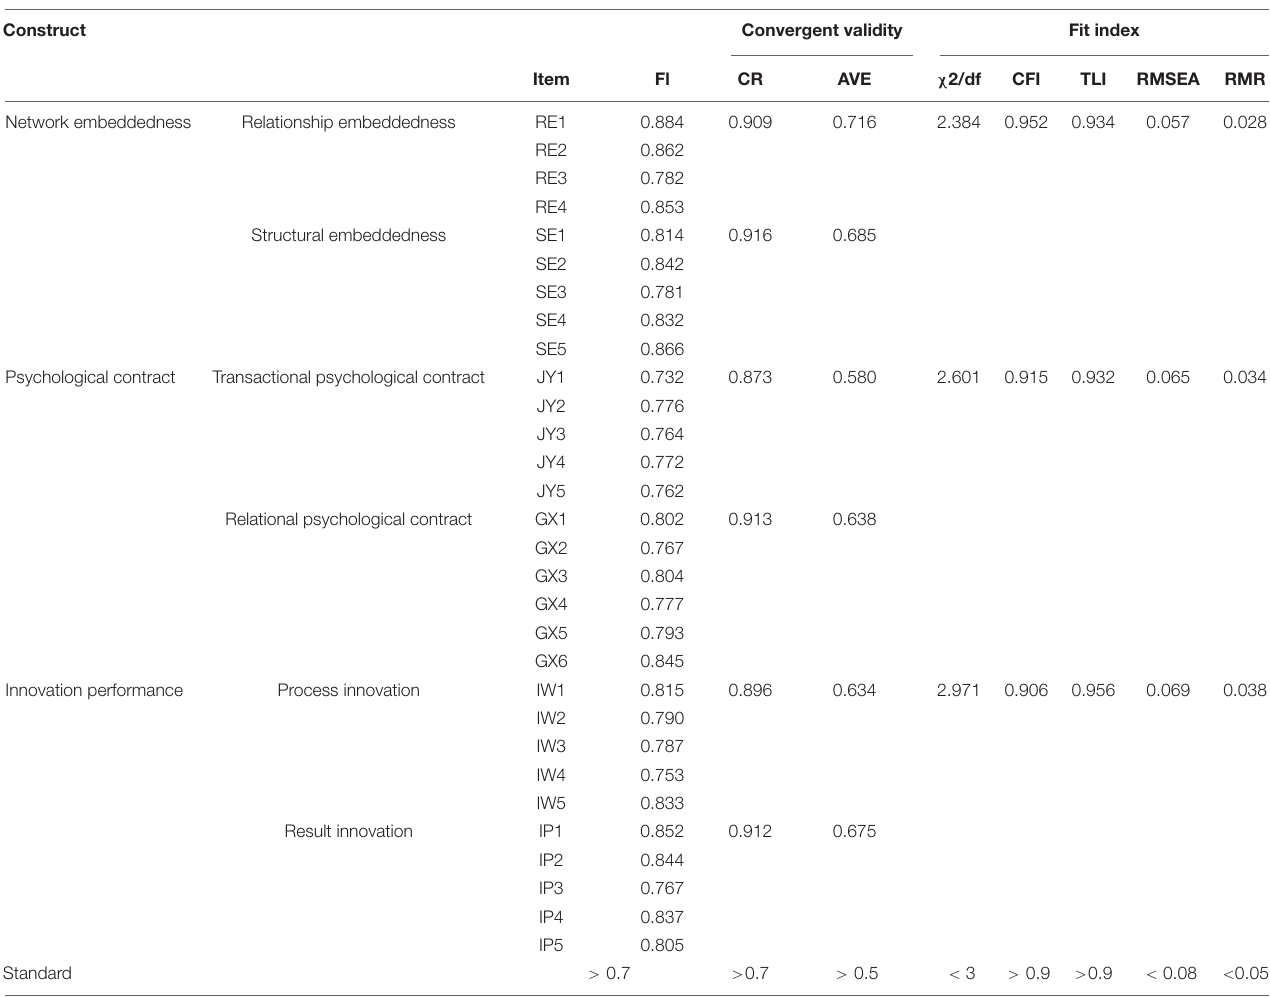
TABLE 2 | Results of confirmatory factor analysis.